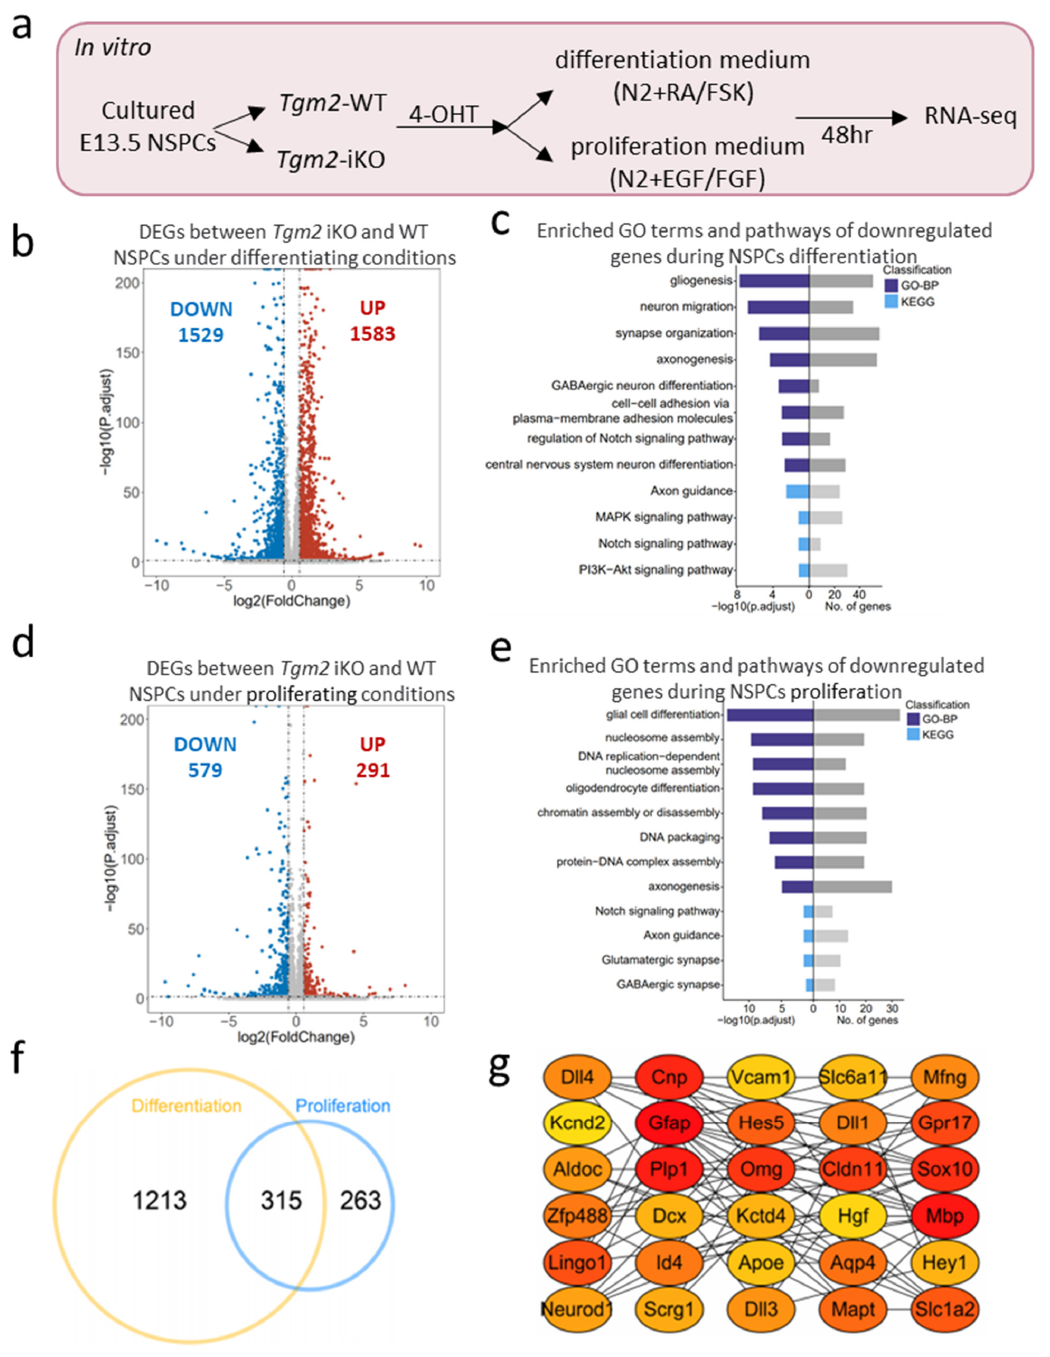
Figure 5. Tgm2 -deletion alters the expression of genes related to cell proliferation and neural differ- entiation. ( a ) Workflow diagram for transcriptome sequencing of Tgm2 iKO and WT NSPCs under proliferating or differentiating conditions. ( b ) Volcano plot illustrating the differentially expressed genes (DEGs) between Tgm2 iKO and WT NSPCs under differentiating conditions. Red, upregulated genes; Blue, downregulated genes. ( c ) Bar plot depicting the significantly enriched GO terms (bio- logical processes, BP) and KEGG pathways of downregulated genes during neural differentiation of TGM2-null NSPCs. ( d ) Volcano plot illustrating the DEGs between Tgm2 iKO and WT NSPCs under proliferating conditions. Red, upregulated genes; blue, downregulated genes. ( e ) Bar plot depicting the significantly enriched GO terms (biological processes, BP) and KEGG pathways of downregulated genes during proliferation of TGM2-null NSPCs. ( f ) Venn plot illustrating the co-downregulated genes in processes of proliferation and differentiation. ( g ) Netplot depicting the linkages of TOP 30 co-downregulated genes as a network in processes of cell proliferation and neural